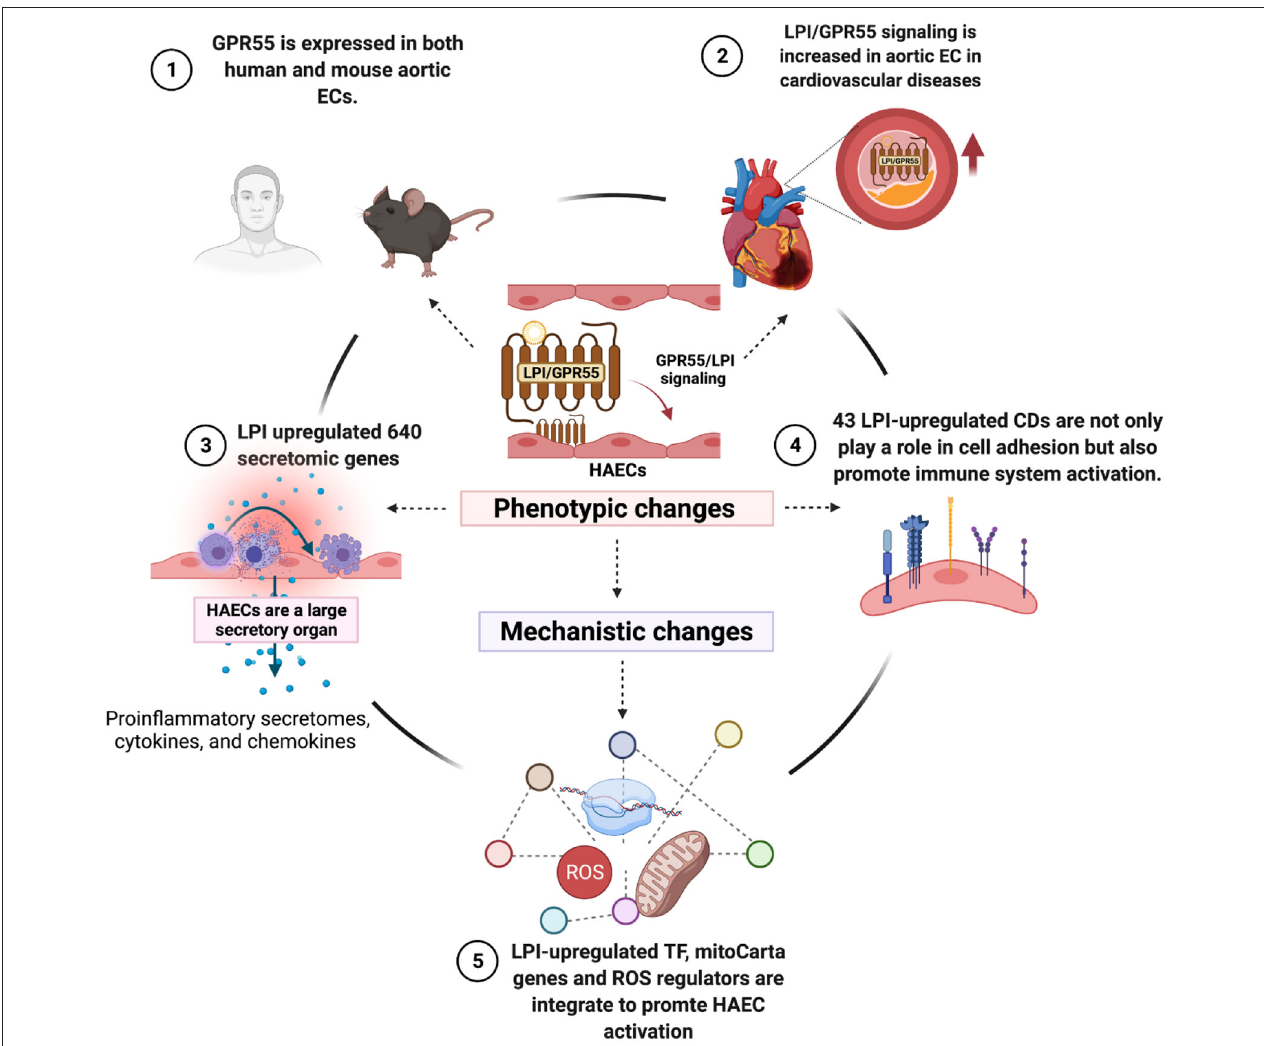
FIGURE 11 | Working model. LPI receptor GPR55 is expressed in both human and mouse aortic endothelial cells. LPIs/GPR55 signaling is upregulated in aortic endothelial cells in hyperlipidemia. We first proposed human aortic endothelial cells as a large secretory organ, which can mediate up to 640 secretomic genes upon LPI stimulation. A large number of secretory proteins contribute a significant role in mediating EC activation and inflammation. LPI-stimulated specific CD markers not only participate in cell adhesion but also play an essential role in immune cell activation, proliferation, and differentiation. All these phenotypic changes may be caused by the mechanisms of synergy among LPI-increased TFs, mitoCarta genes, and ROS regulators. *This figure was created with